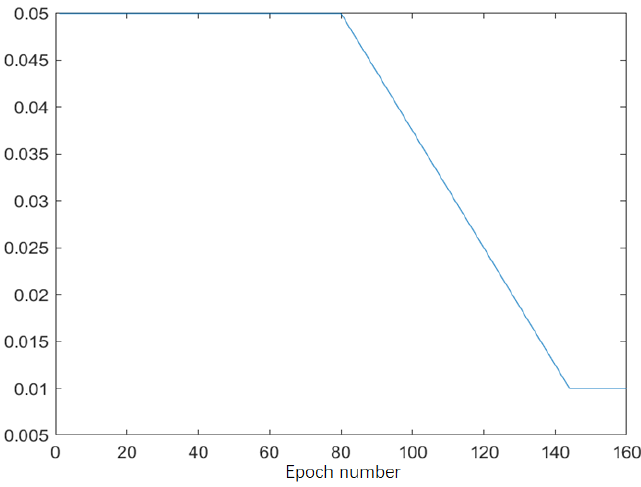
Figure A1. An example of the learning-rate schedules used in our